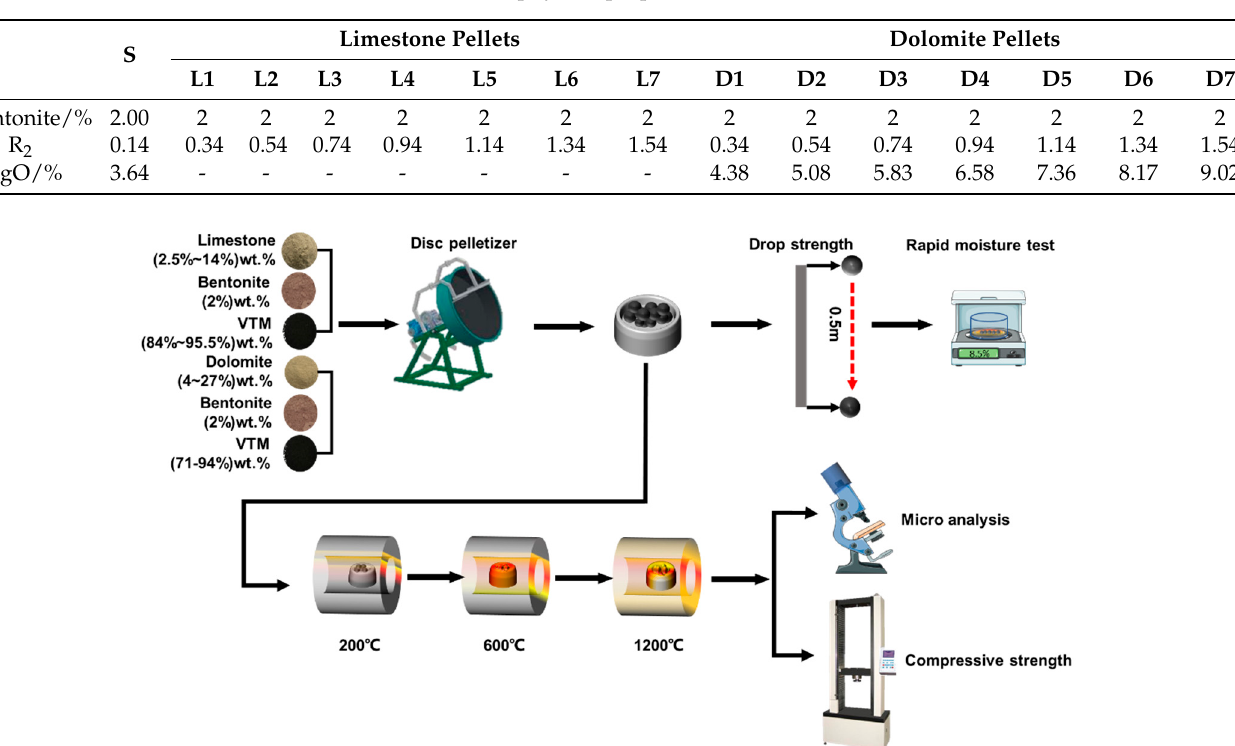
Table 4. Main chemical reactions.